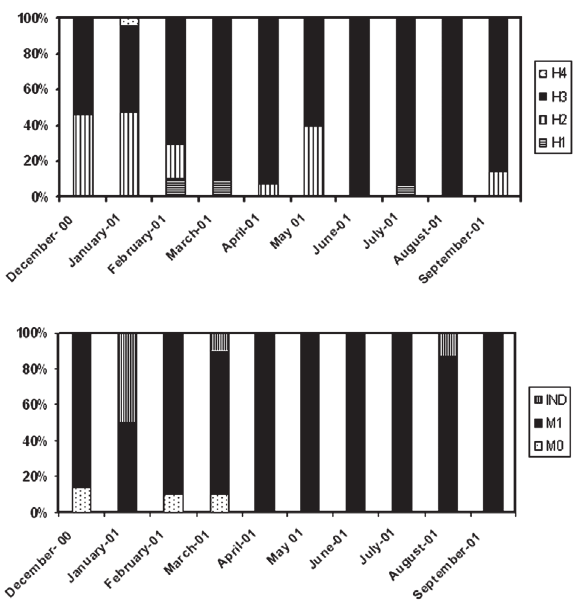
Fig . 7 . – temporal trends of the percentage for each gonadal stage at Palmeral. (a) Females; h1, spent condition; h2 phase of oocyte maturation; h3, mature state with ova; h4, phase of gonadal recon- stitution with maximum thickness of the nutritive layer. (B) Males and immature specimens (lacking gametes); M0, spent condition; M1, mature gonad with